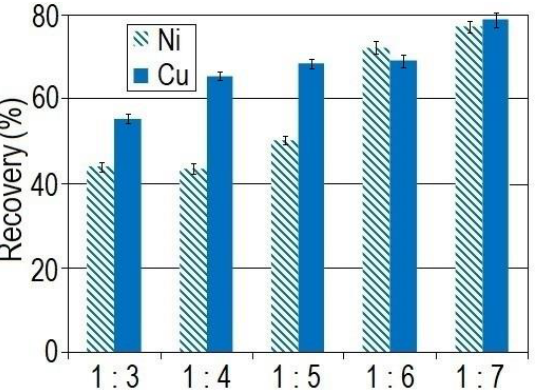
Figure 9. Recovery of metals into solution depending on the concentrate to ammonium sulfate mass ratio at a roasting temperature of 400 °C.